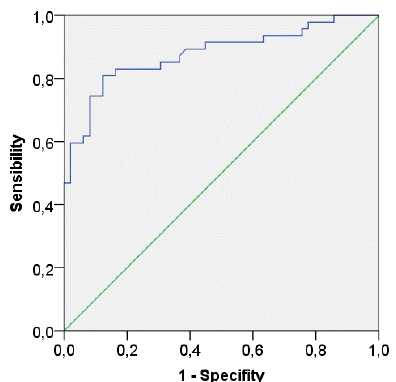
Fig. 1: ROC curve constructed from sensitivity and 1-specifity